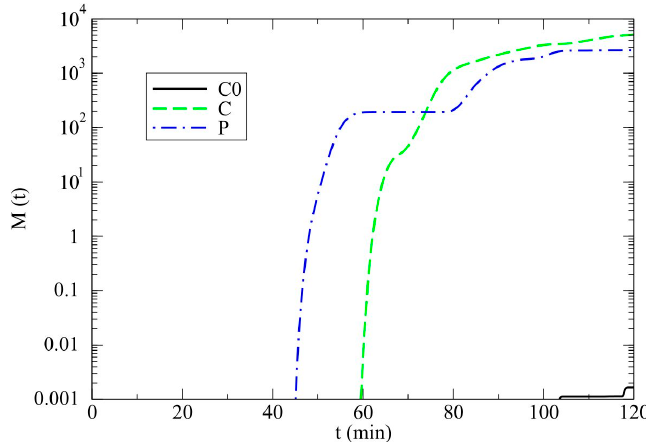
Figure 11. As in Figure 5, but for the cumulative sum of hail melting (tonnes).